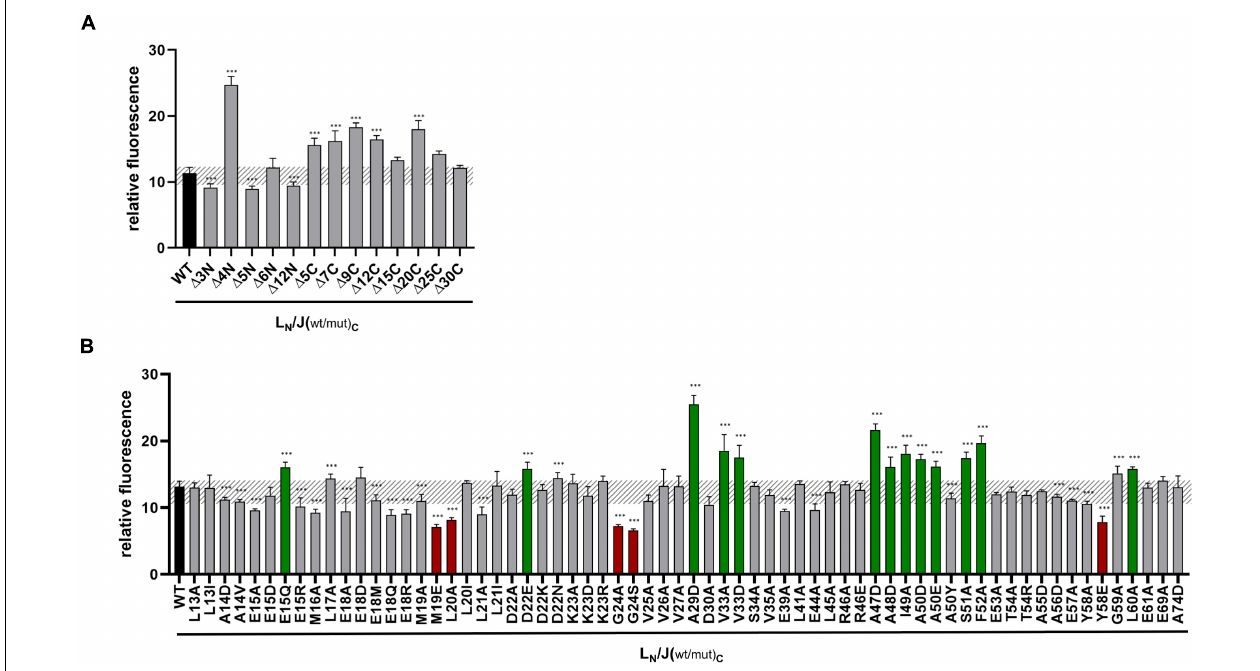
FIGURE 3 | Split-GFP analyses of GvpL and variants of GvpJ. (A) Rf values of GvpL and deletion variants of GvpJ. The wild type version L C /J N is labeled in black. L C , CGFP is fused to the C-terminus of GvpL; J N , NGFP to the C-terminus of GvpJ. (B) Rf values of L/J wt (black) and the various L/J mut Hfx. volcanii transformants with single substitutions in GvpJ. The respective substitution is marked on the bottom. Transformants showing a significantly lower fluorescence are labeled in red, and transformants with a higher fluorescence are in green. The significance of the rf values was calculated by Student’s t -test against wild type. ∗∗∗ extremely significant = p ≤